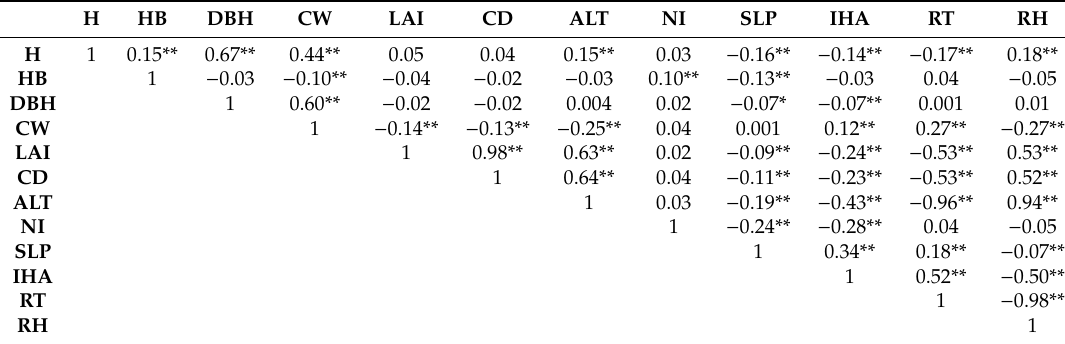
Table A3. Spearman correlations among explanatory